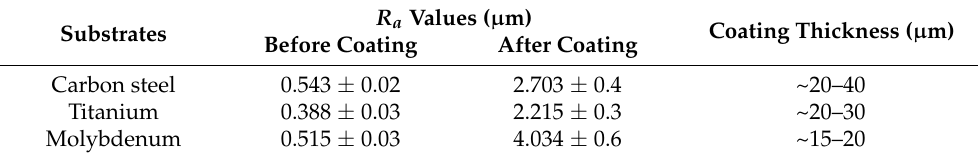
Table 7. Surface roughness measurements of substrates and coatings.